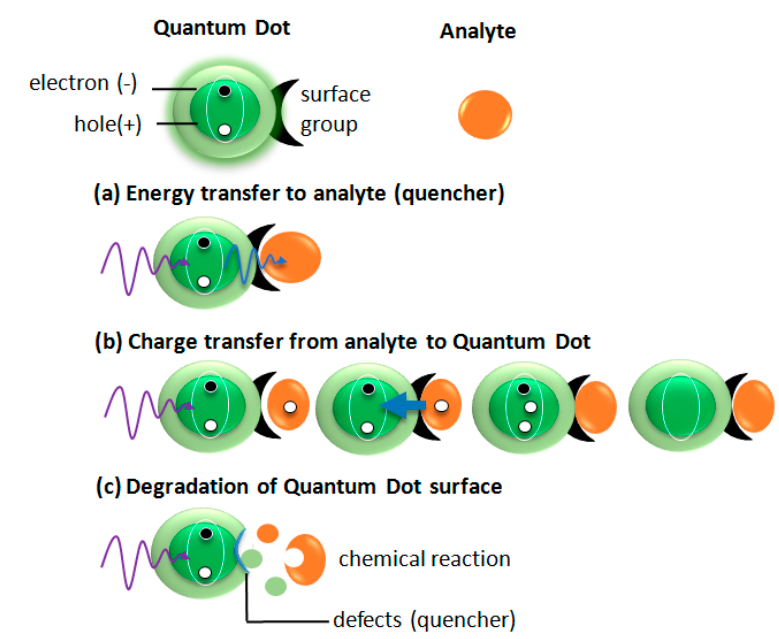
Figure 6. Examples of physico-chemical mechanisms responsible for quantum dots emission quenching—energy transfer from QD to analyte ( a ), charge transfer from analyte to QD ( b ), degradation of QD surface ( c ).